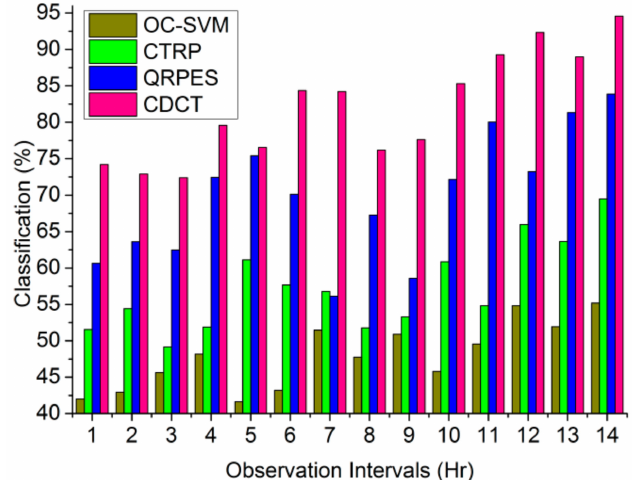
Figure 9. Emission Data